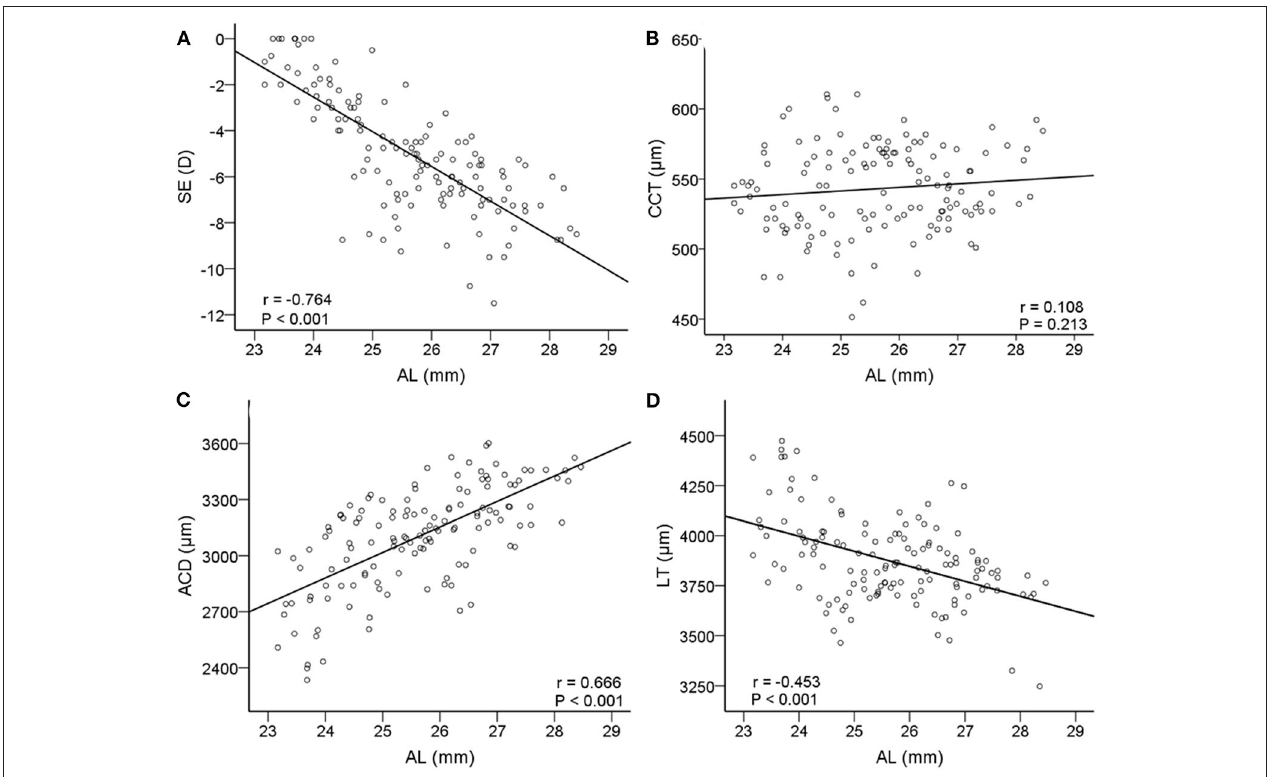
FIGURE 3 | Correlations between axial length (AL) and other relative biometric parameters. Scatterplots showing AL vs. (A) spherical equivalent (SE); (B) CCT; (C) ACD; (D) LT. AL, axial length; SE, spherical equivalent; CCT, central corneal thickness; ACD, anterior chamber depth; LT, lens